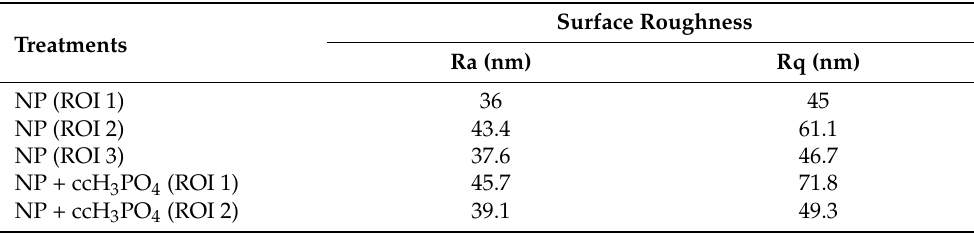
Table 4. Surface roughness measured using AFM. Three regions of interest (ROI) were randomly selected on the untreated control and two on the ccH 3 PO 4 -treated NP surface for analysis. The treatment of NP surface with ccH 3 PO 4 did not affect the surface roughness apparently.